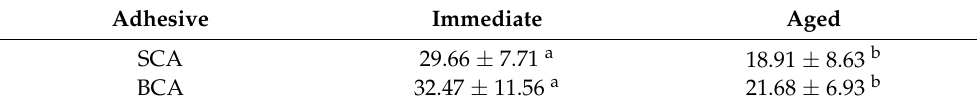
Table 3. Micro-tensile bond strengths of both experimental groups (n = 20, unit: MPa). Adhesive